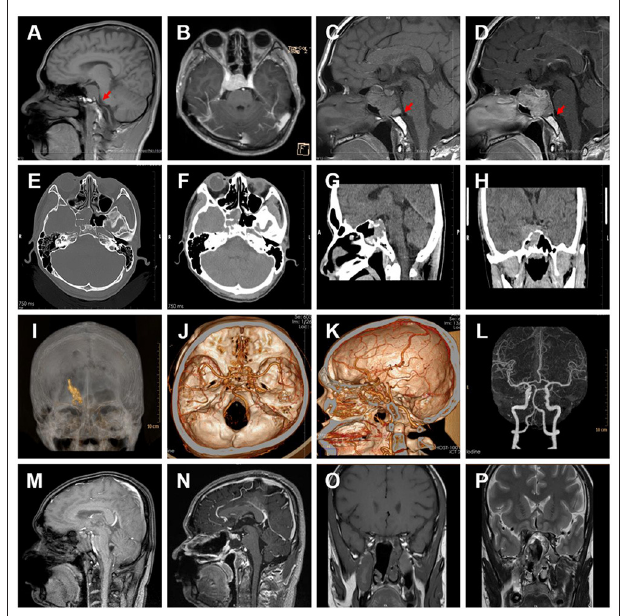
FIGURE 1 | (A) MRI T1-weighted image from 2018-08-01, with the meningeal caudal sign in the red arrow. (B) MRI T1-weighted image from 2018-08-13. (C) MRI T1-weighted image from 2021-06-01. (D) MRI T1-weighted enhanced image from 2021-06-01, with the meningeal caudal sign in the red arrow. (E–H) CT images with the bone window. (I–K) 3D reconstruction of CT scan shows the tumor was posterior to the basilar artery, anterior to the hypophysial stalk, and surrounded by the internal carotid artery. (L) Pre-operative CTA contrast imaging. (M–P) Postoperative images.